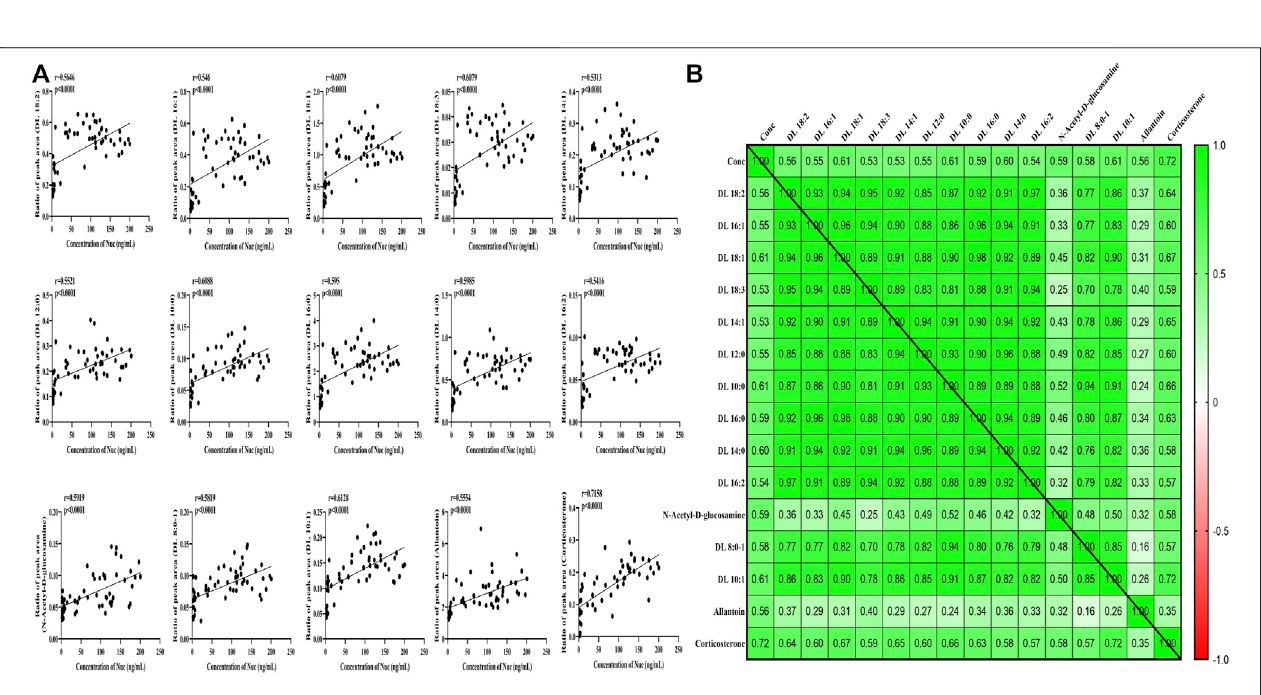
FIGURE 5 | Correlation analysis between signi fi cantly changed metabolites and concentration of Nuc. (A) Correlation values. (B) Heat map of disturbed metabolites.